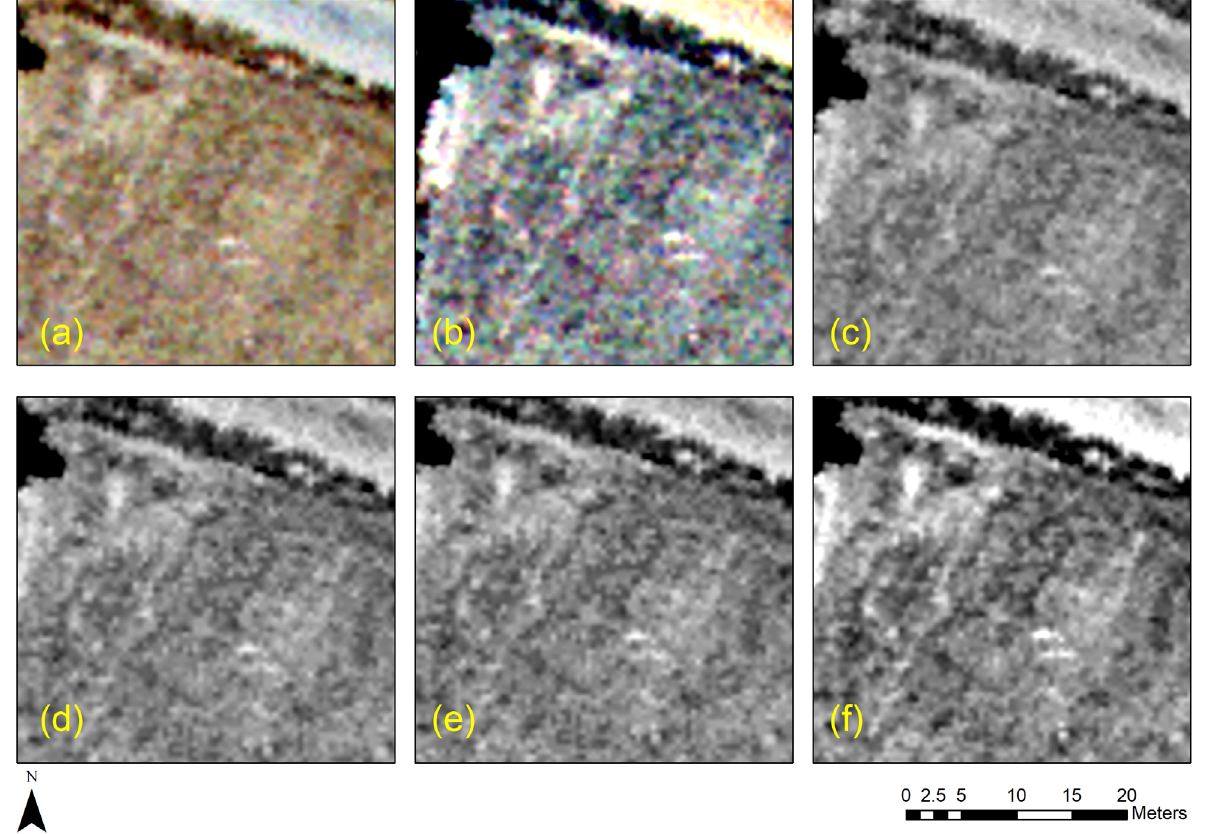
Figure 7: (a) R-G-B pseudo colour of the aerial image 1968 (standard deviation histogram stretch); (b) B-G-R pseudo colour of the aerial image 1968 (standard deviation histogram stretch); (c) Blue band of the aerial image 1968 (standard deviation histogram stretch); (d) Green band of the aerial image 1968 (standard deviation histogram stretch); (e) Red band of the aerial image 1968 (standard deviation histogram stretch); (f) First Principal Component (PC1) of the aerial image 1968 (standard deviation histogram stretch).